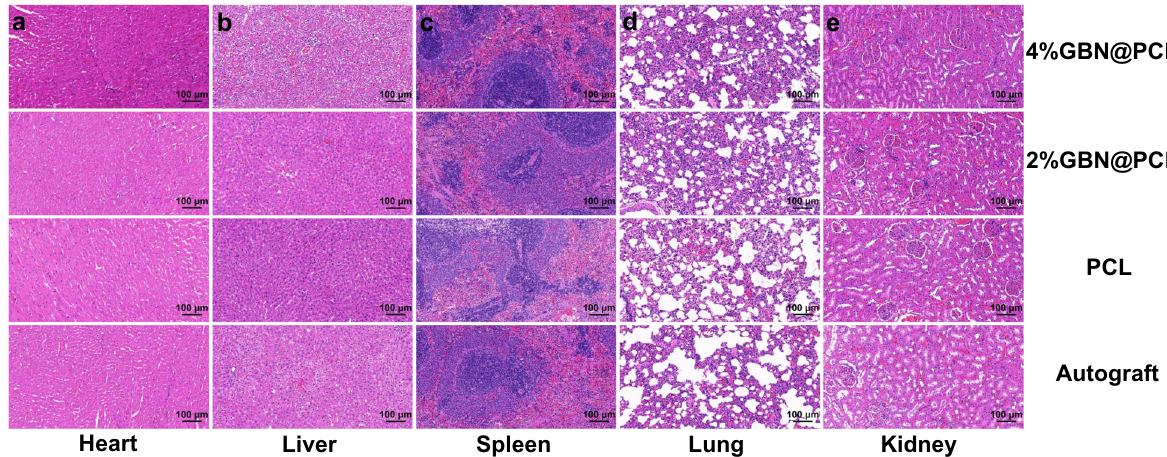
Fig. 1 Toxicity effect of GBN in a peripheral nerve defect. Histology of major functioning organs (heart, liver, spleen, lung, and kidney) after 18-month scaffold or autologous nerve graft implantation in vivo using HE staining ( a – e